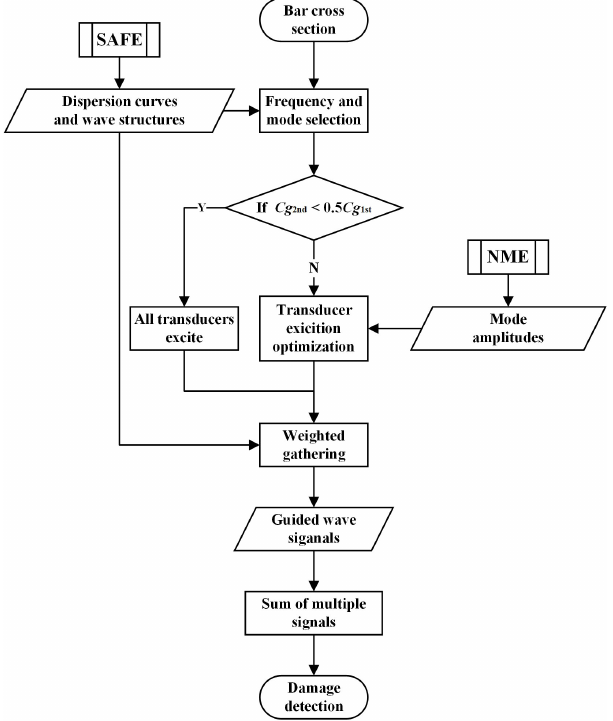
Figure 1. Process of the proposed